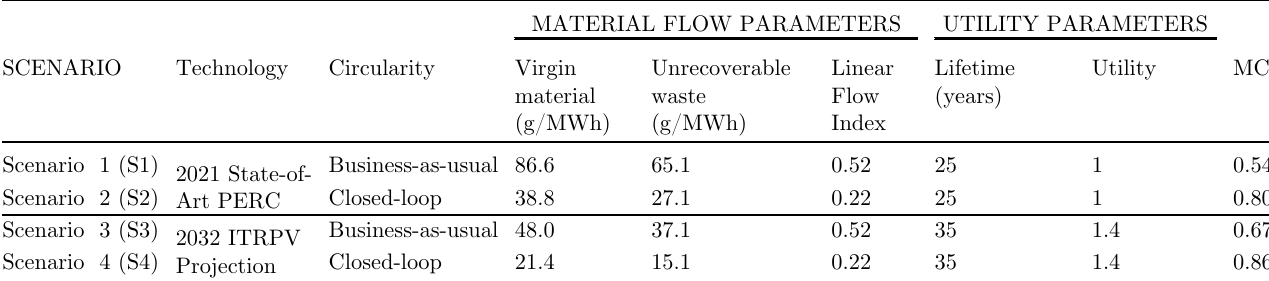
Table 3. Results of MCI (FU = 1 MWh) and its